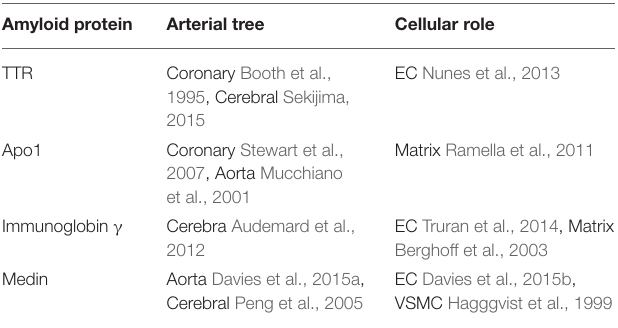
TABLE 1 | The relationships among the four kinds of amyloid proteins, the arteries likely deposited, the cells likely involved and references. Amyloid protein Arterial